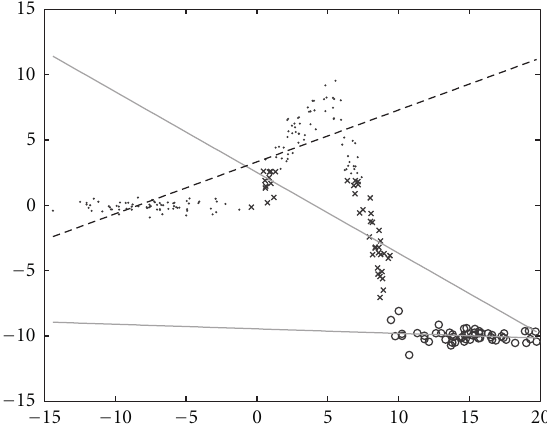
Figure 6: Initialization of hyperplane clustering for M = 3. Patterns belonging to the new generated clusters are represented by the symbols “x” and “o”, respectively; the first estimate of hyperplanes based on these subsets is shown by the continuous gray lines. Patterns represented by simple dots belong to the cluster associated with the hyperplane that has not been split (dashed